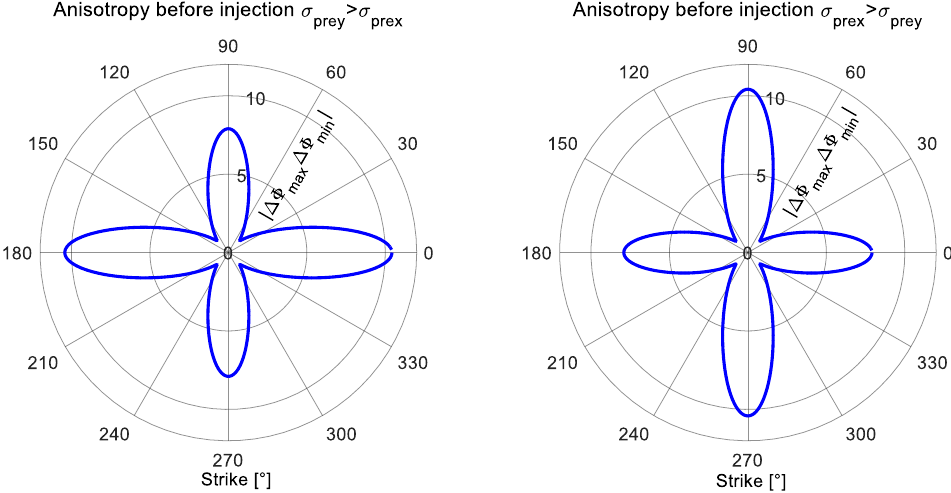
Figure 18. Sensitivity analysis of the anisotropy model before injection to the residual phase tensor.